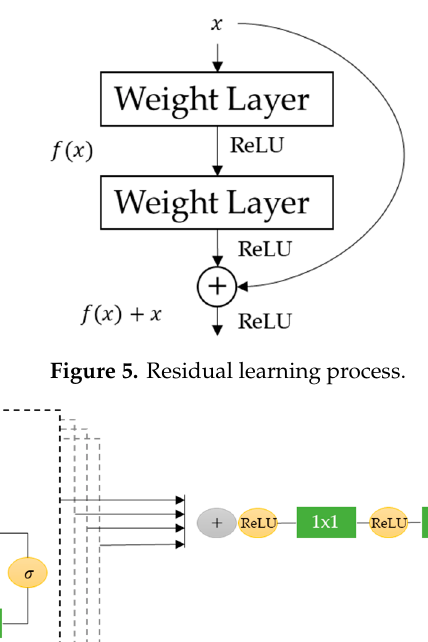
Figure 5. Residual learning process.